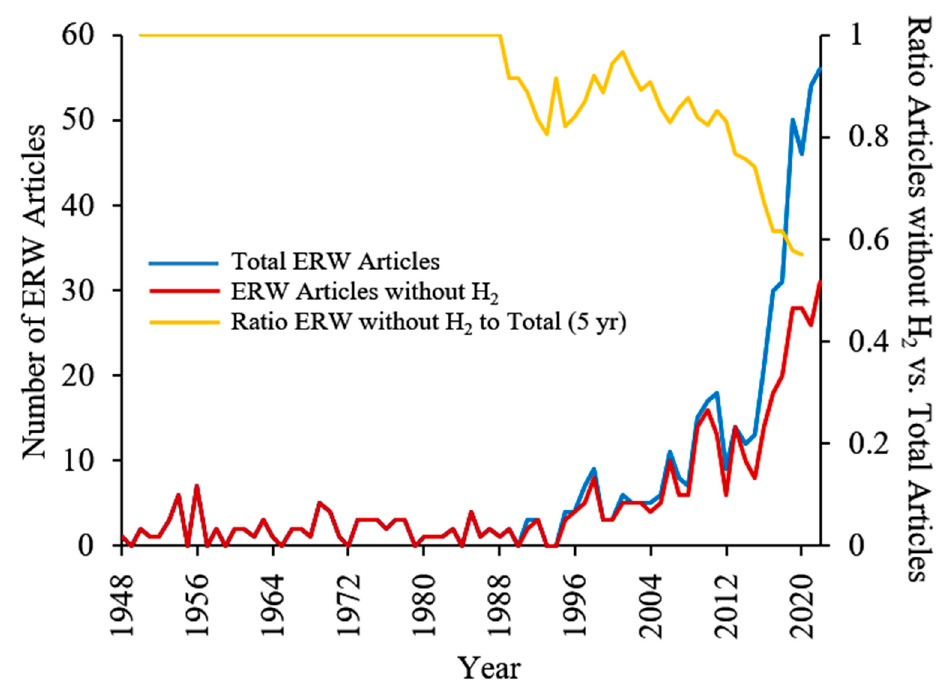
Figure 3. The annual number of ERW articles with or without hydrogen in the title or abstract from 1948 to 2022. ERW articles are defined as having “alkaline (ionized) water” or “electrolyzed reduced water” in the title. The presence or absence of “hydrogen” was searched for either in the title or abstract. The ratio of ERW articles without hydrogen to the total number of ERW articles represents an average of 5 years.